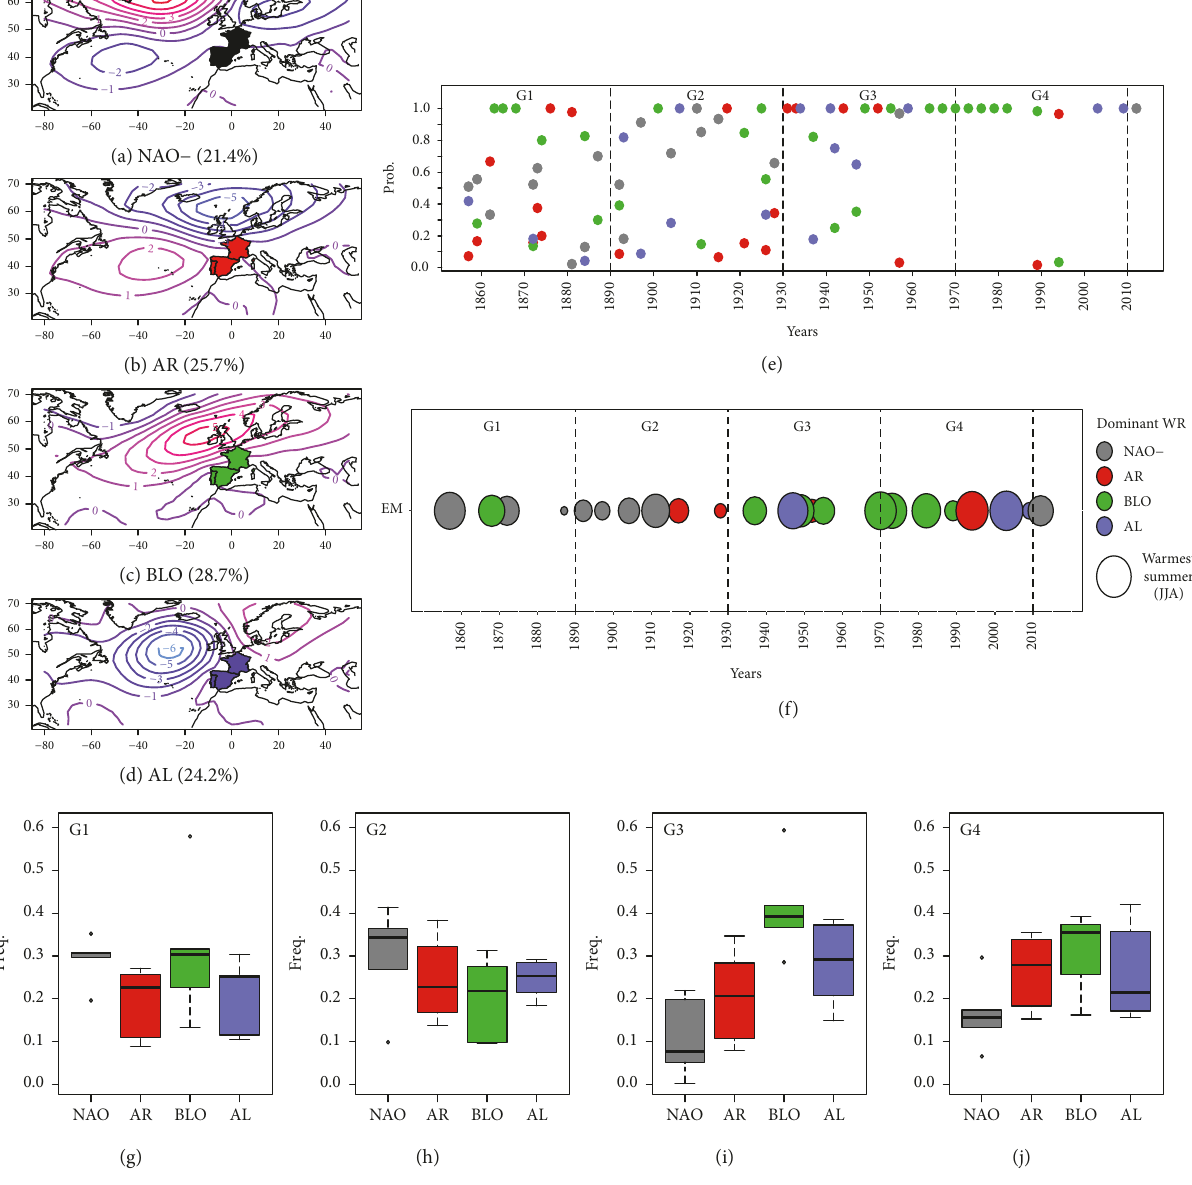
Figure1:SummerSLPweatherregimesovertheNorth-Atlanticregionandtheirdominanceinthetwentywarmestsummersduring1871–2011 in Western Europe. (a)–(d) Summer SLP (hPa anomalies) weather regimes. (a) North-Atlantic oscillation in its negative phase (NAO − ). (b) Atlantic Ridge (AR). (c) Blocking (BLO). (d) Atlantic Low (AL) weather regime. (e) Probability to find a dominant weather regime in all the warmest summers (EM and 56 members). (f) 24 warmest summers in Western Europe (colored region in (a)–(d)) with their dominant weather regime (20CRv2c EM). Circle size depends on temperature (anomalies), the largest the warmest. Colors represent the dominant weather regime for each summer based on the highest anomalous frequency. (g)–(j) Boxplots of daily weather regimes during the 24 warmest summers of 20CRv2c EM (as in (f)) in Western Europe separated by groups of 6 summers per 40 years: (g) shows group G1, (h) group G2, (i) group G3, and (j) group G4